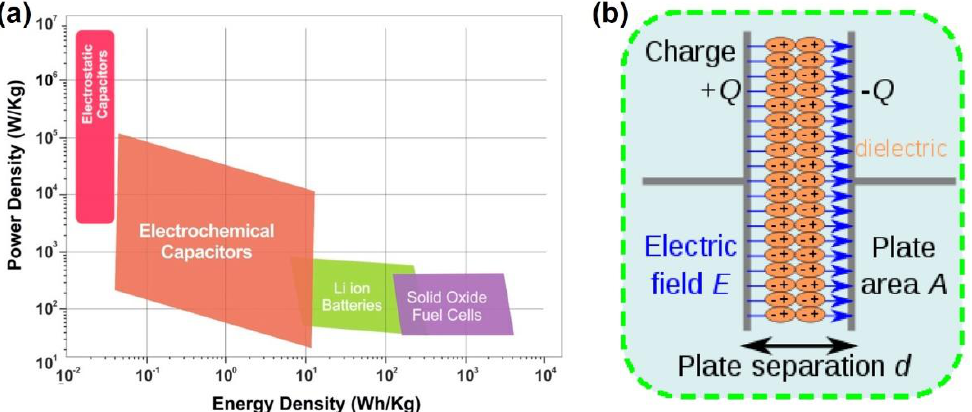
Figure 1. ( a ) Sketch of a Ragone plot for various energy storage device systems. Reproduced with permission from Ref. [11]. Copyright 2017, American Institute of Physics. ( b ) The diagram of charge separation in a parallel-plate capacitor under the function of an electric field. Reproduced with permission from Ref. [1]. Copyright 2013, World Scientific.